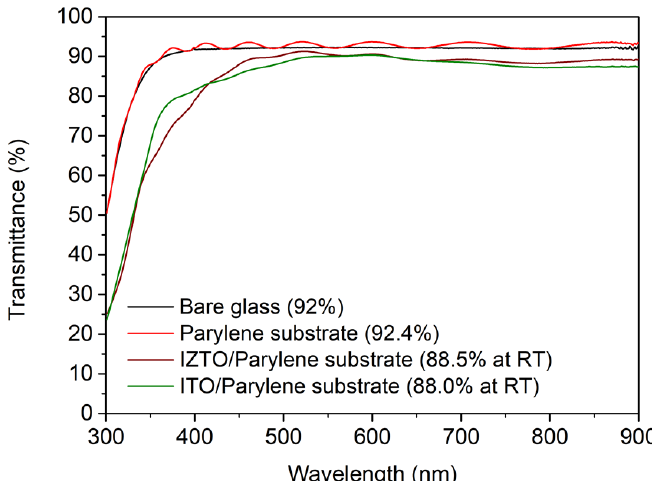
Figure 1. Transmission spectra of the bare glass, parylene free-standing film, the IZTO, and ITO films grown at room temperatures on the parylene substrates, respectively.